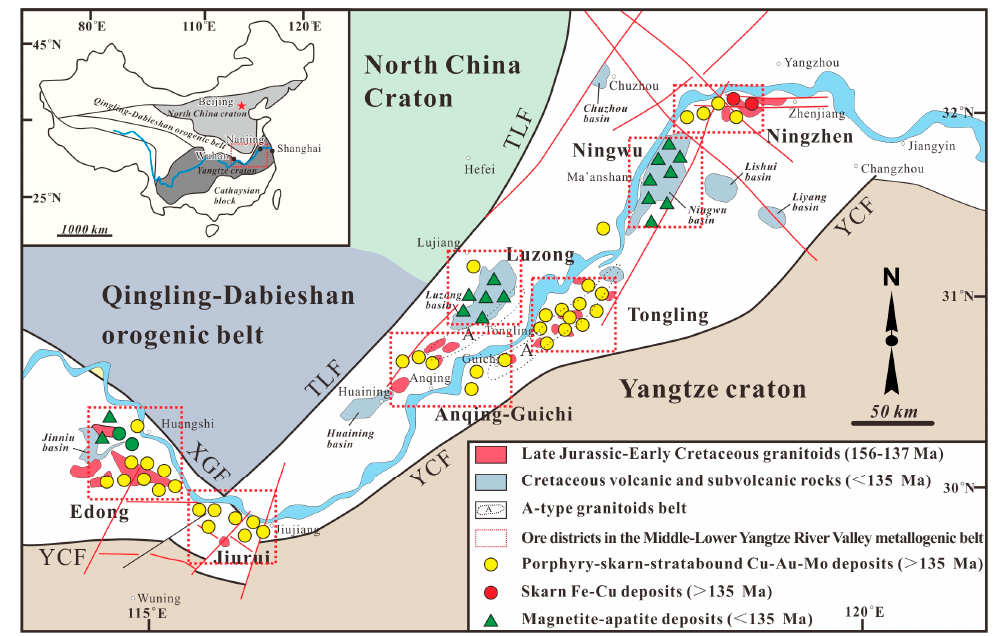
Figure 1. Location of the Tongling ore district in the Middle–Lower Yangtze River Valley metallogenic belt (after [26]). TLF: Tancheng–Lujiang fault; XGF: Xiangfan–Guangji fault; YCF: Yangxing–Changzhou fault.